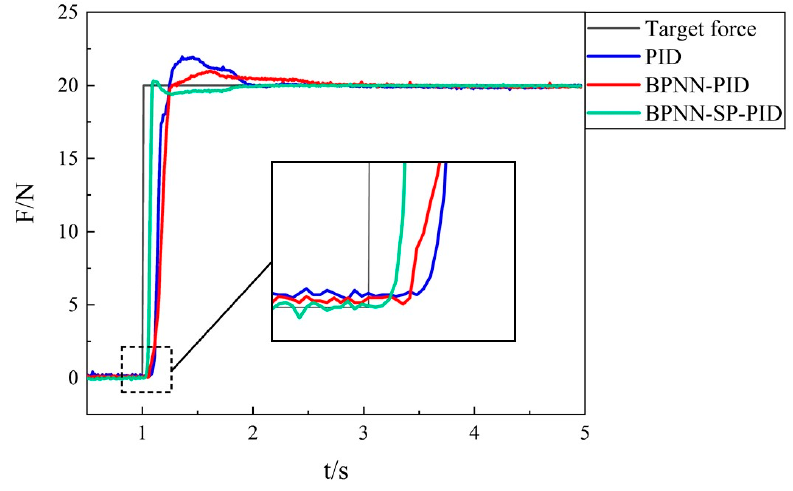
Figure 16. Comparison of the step responses of three controllers in the